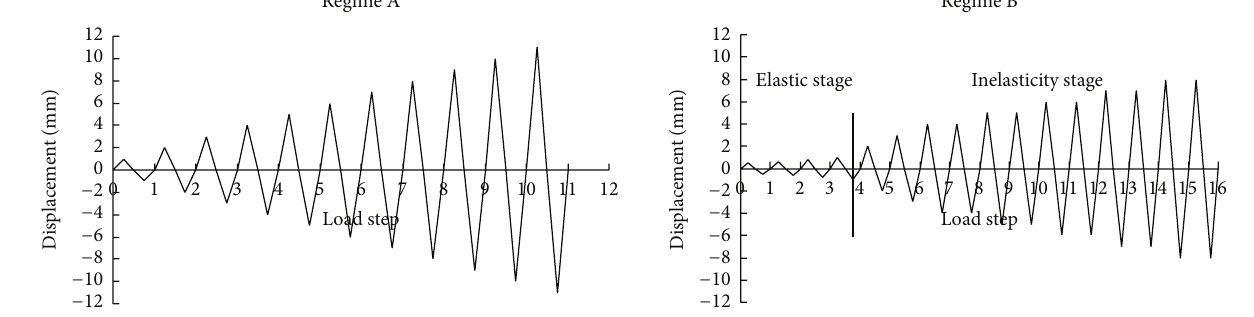
Figure 3: Loading history of specimens. Table 2: Characteristics of